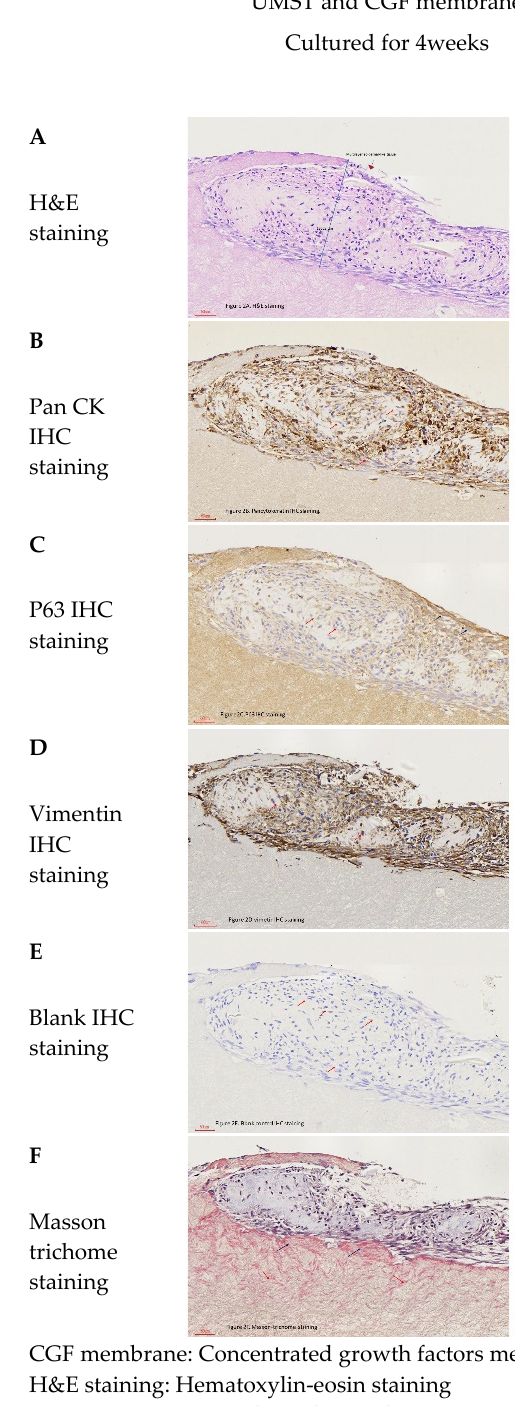
Figure 2. Human Wharton’s jelly umbilical cord mesenchymal stem cells were implanted on the concentrated growth factors membrane and cultured for four weeks. Multi-layer epidermal-like tissue was formed on the surface of the concentrated growth factors membrane. Tissue sections were prepared from these tissue samples from the in vitro culture preparation. Hematoxylin–eosin staining, pancytokeratin and P63 cell marker immunohistochemical staining were performed. The results were compared with those from blank controls. Figure 2A: After four weeks of in vitro culture, multi-